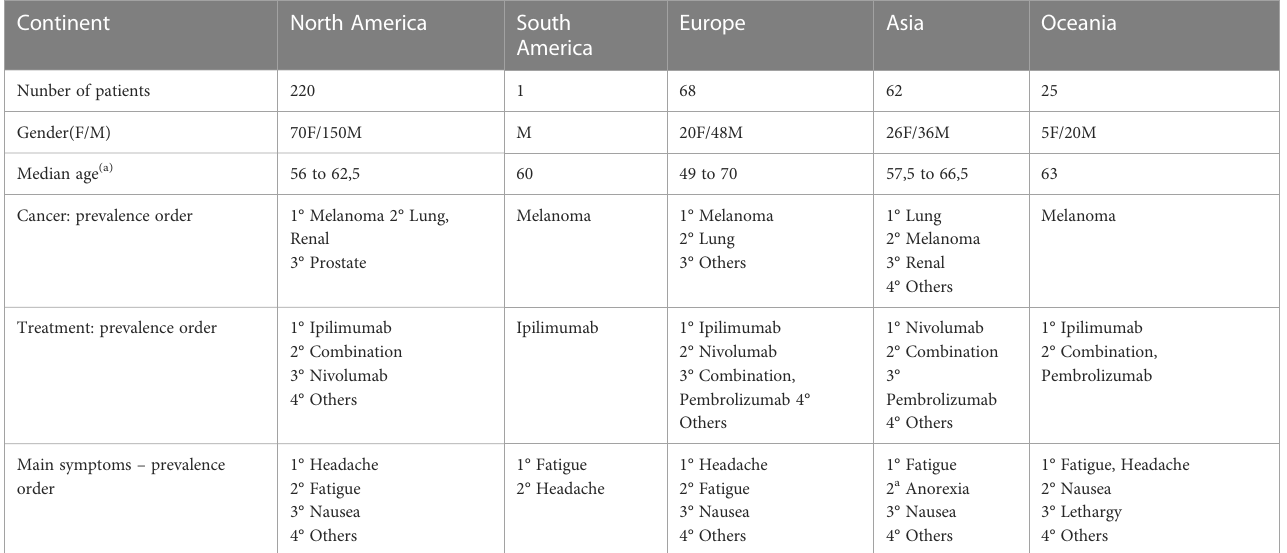
TABLE 4 Information of the case studies, case series and cohort studies describing individual cases, grouped by continent – Part